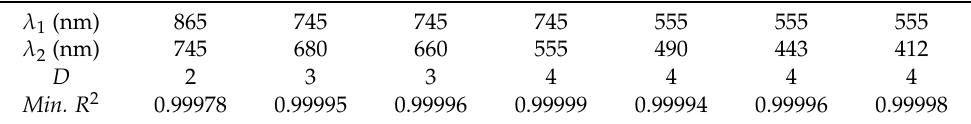
Table 2. Degree of the polynomial Equation (26) for Geostationary Ocean Colour Imager (GOCI) wavelengths